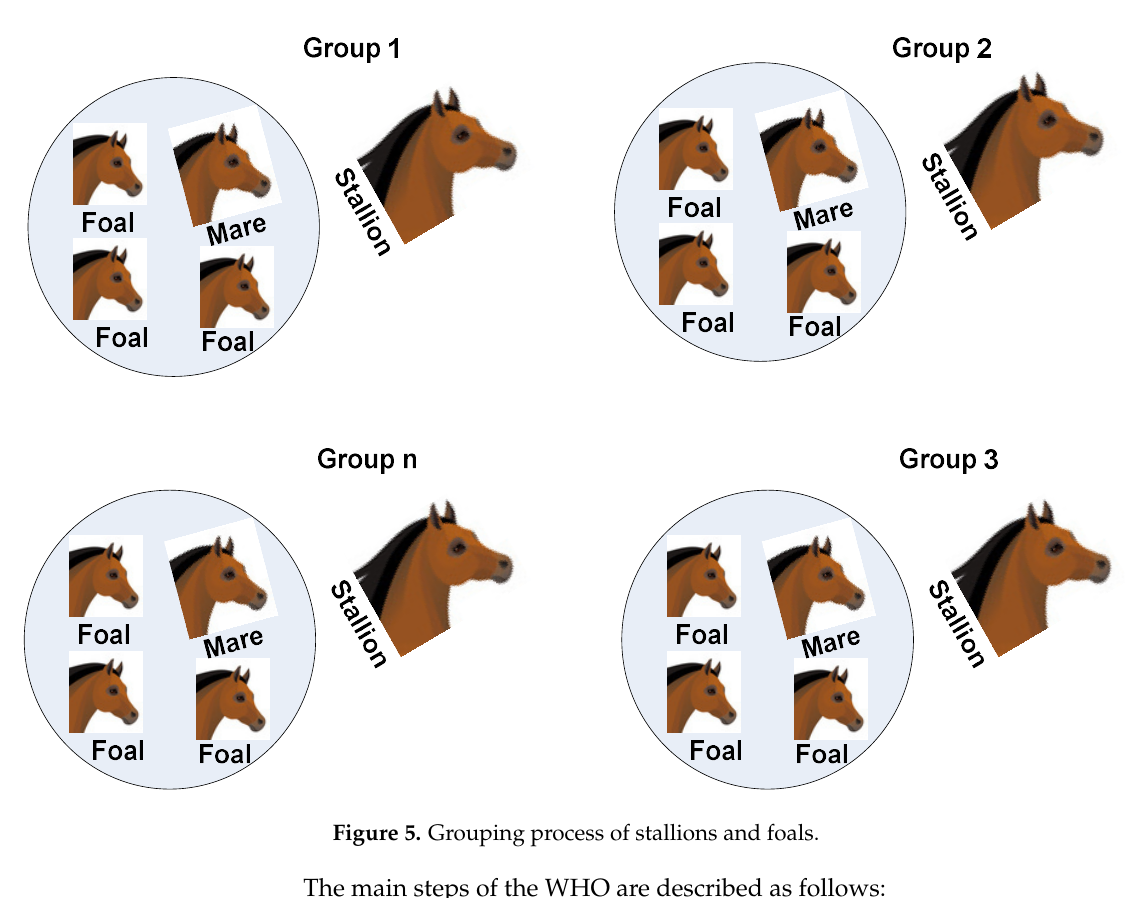
Figure 5. Grouping process of stallions and foals.